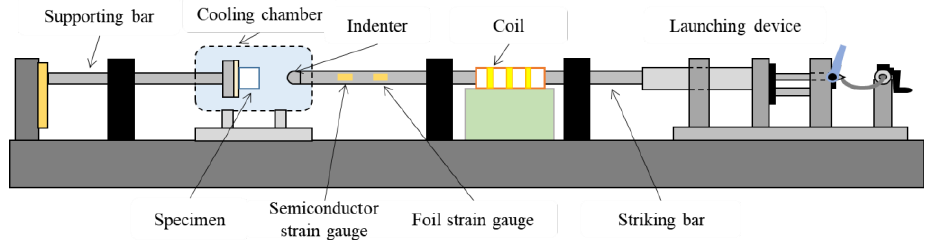
Fig. 1. Schematic of impact indentation test using the direct impact Hopkinson bar